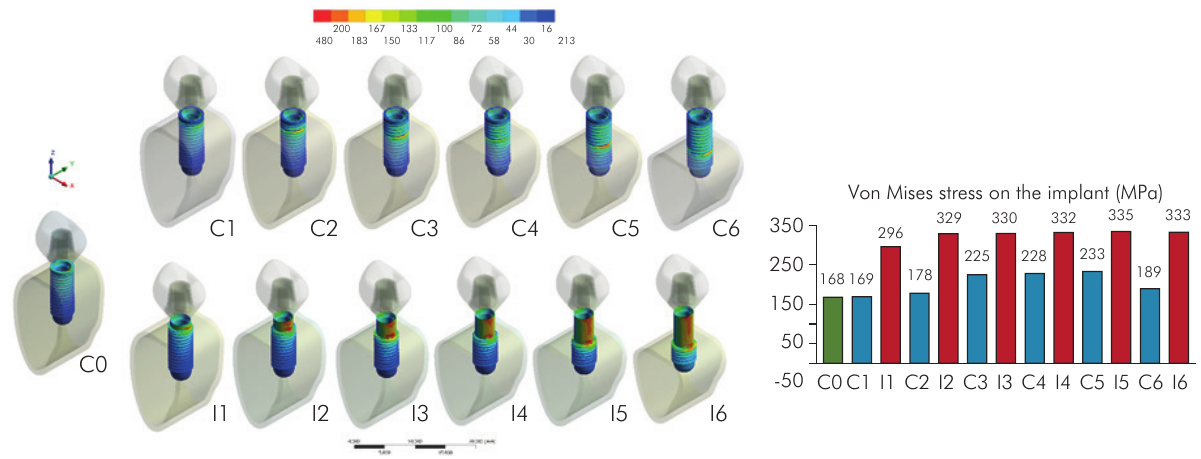
Figure 3. Stress distribution on the implant according to von Mises stress criteria for all groups.